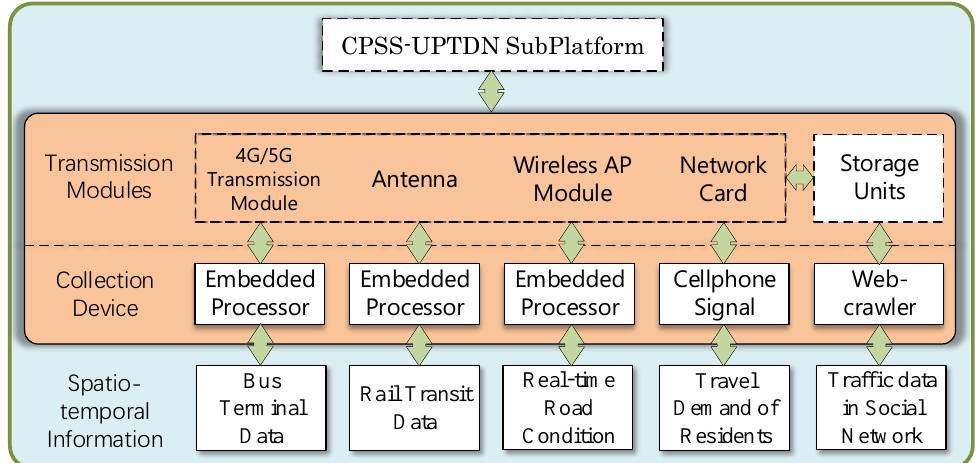
Figure 2. Data collection and transmission to CPSS-UPTDN